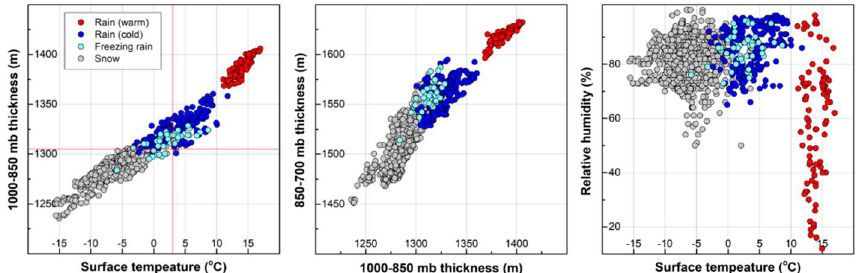
Figure 3. Precipitation classes characterized by the environmental variables retrieved from the numerical weather prediction (NWP) data. The precipitation classes (rain, freezing rain, and snow) were observed at the ground using the ASOS stations in Iowa. The red solid lines indicate the thresholds for surface temperature and critical thickness (1000–850 mb) in the baseline method.